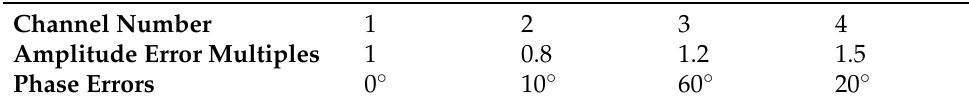
Table 2. Channel amplitude and phase